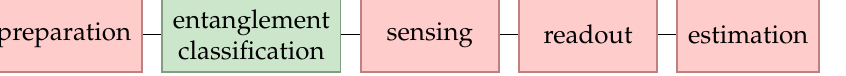
Figure 3. Stages in quantum sensing and metrology with an additional step for detection and classification of resourceful